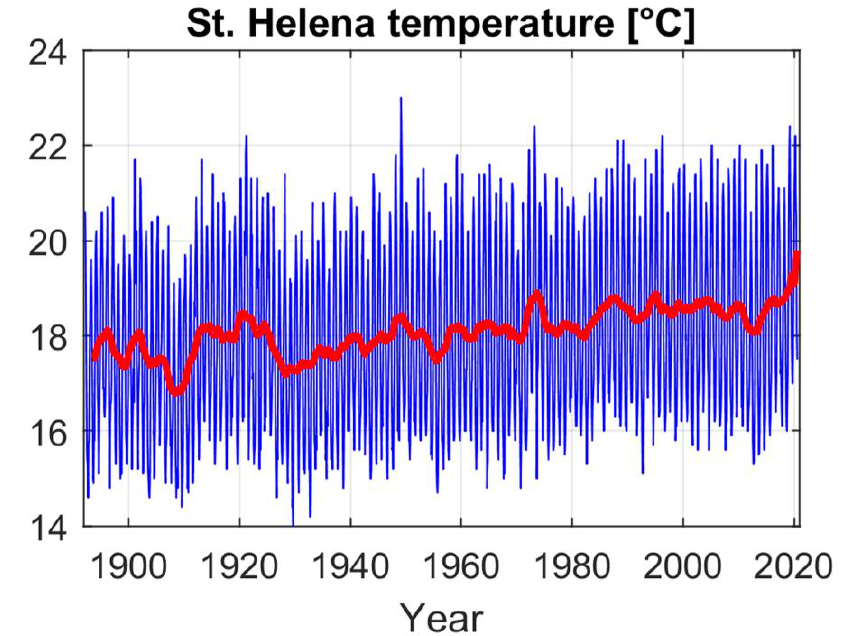
Figure 8. Monthly mean values of the air temperature at St. Helena Island in the South Atlantic [65]; after appearance of the publication the time series has been extended [209]. The bold curve shows the moving average over 3 years. The trend of this local warming amounts to 0.9 °C per